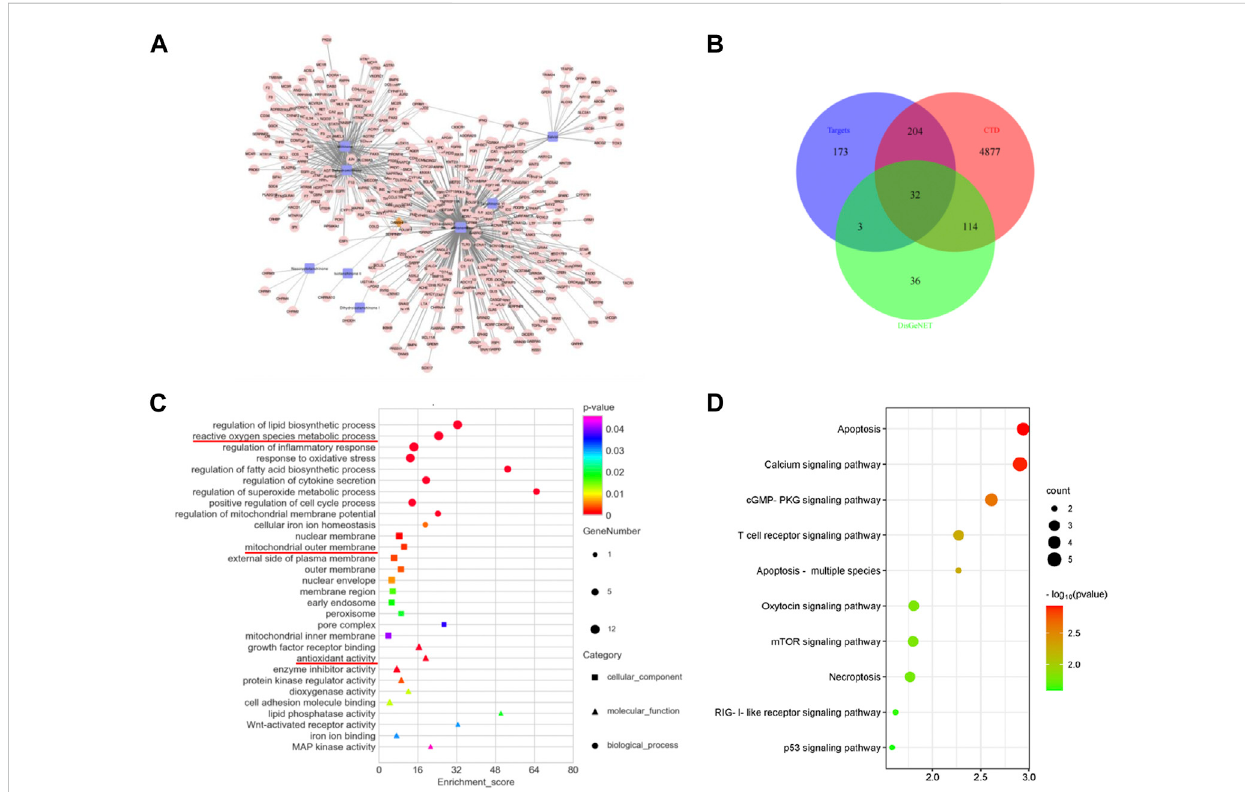
FIGURE 1 OverlappedtargetsandfunctionalenrichmentanalysisbetweenSMandAKI. (A) TargetpredictionandnetworkanalysisofSMcomponents.Atotalof nine key molecules were screened. The brown diamond represents SM, the blue square represents the components, and the pink dot represents the targets. (B) VenndiagramoftheintersectiongenesamongSMtargetsandAKItargetsfromtheDisGeNETandCTDdatabase. (C) GOenrichmentanalysis. The square represents the cellular component, the triangle represents the molecular function, and the circle represents biological process. (D) KEGG enrichment analysis. The vertical axis represents the pathway name, and the horizontal axis represents the number of enriched